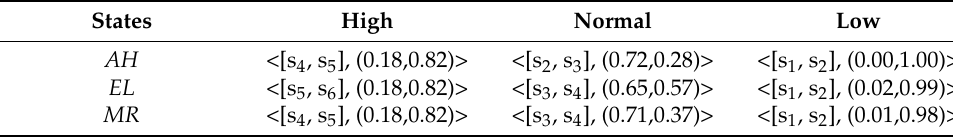
Table 3. The collective knowledge assessment matrix (cid:101) B . States